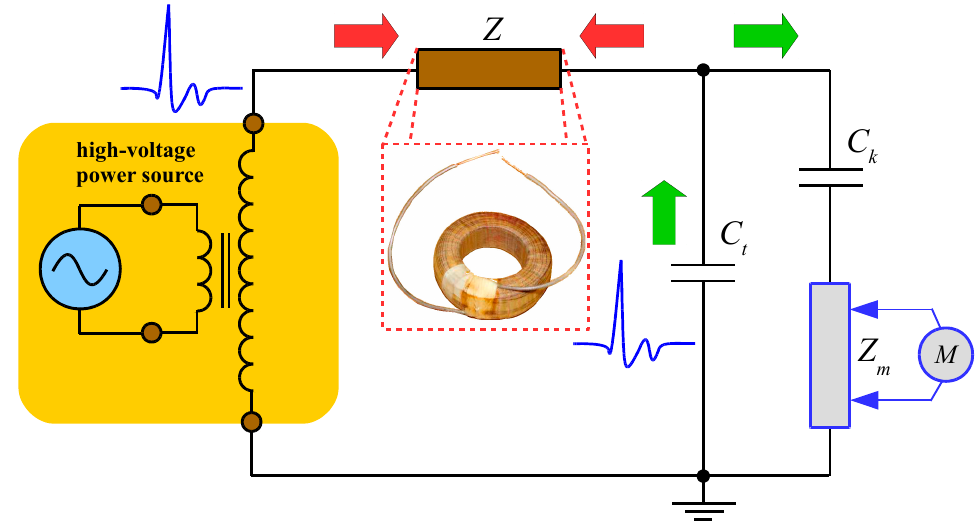
Figure 1. Basic partial discharges (PD) measurement test circuit [17].